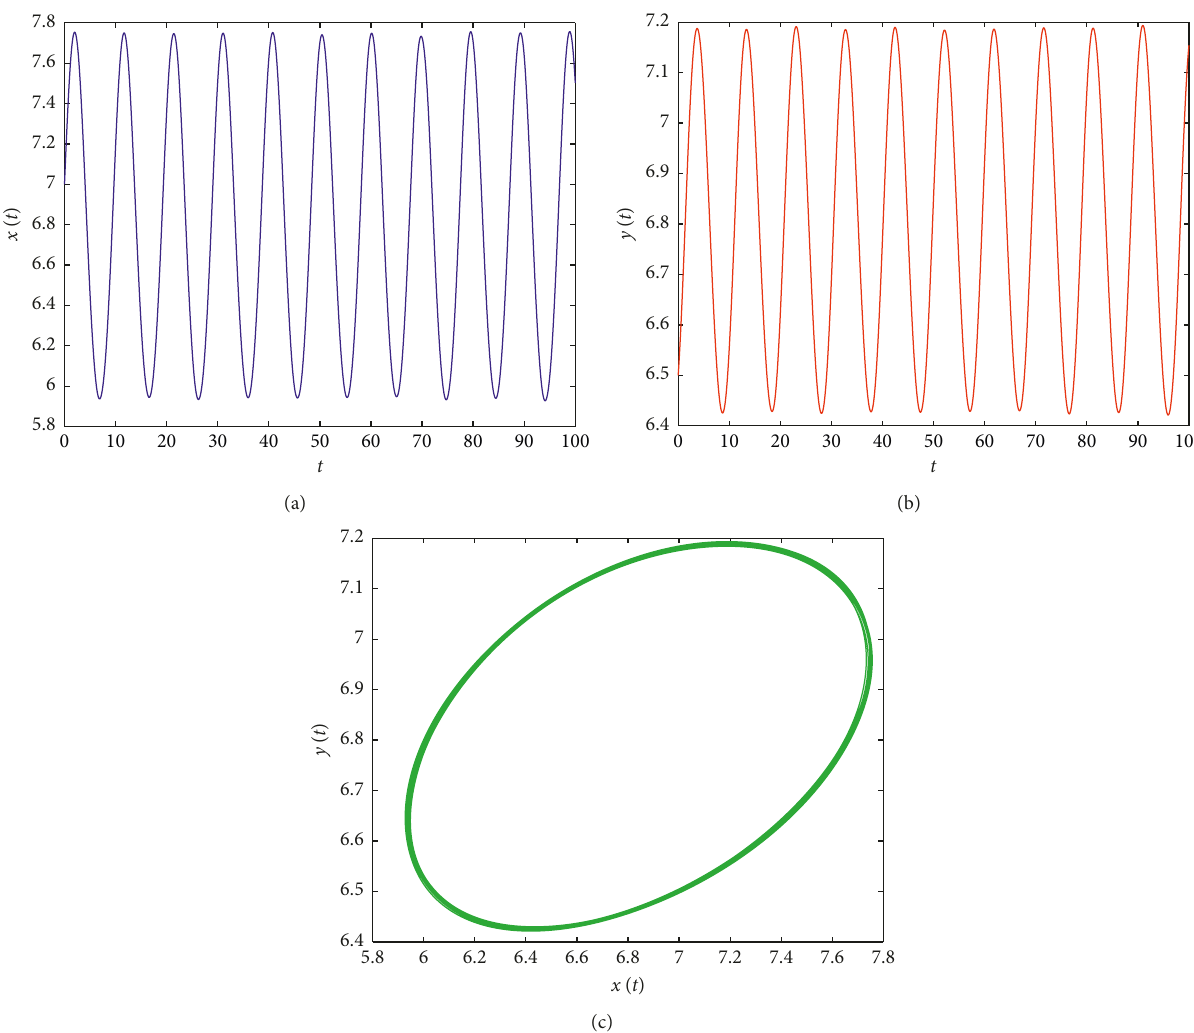
Figure 7: The time series and portrait phase of model (71) when u < Kr /4; here α � 0 . 3 , K � 8 , r � 2, and ( u ) is close enough to 2.04. (a) The time series of x ( t ) ; (b) the time series of y ( t ) ; (c) the portrait